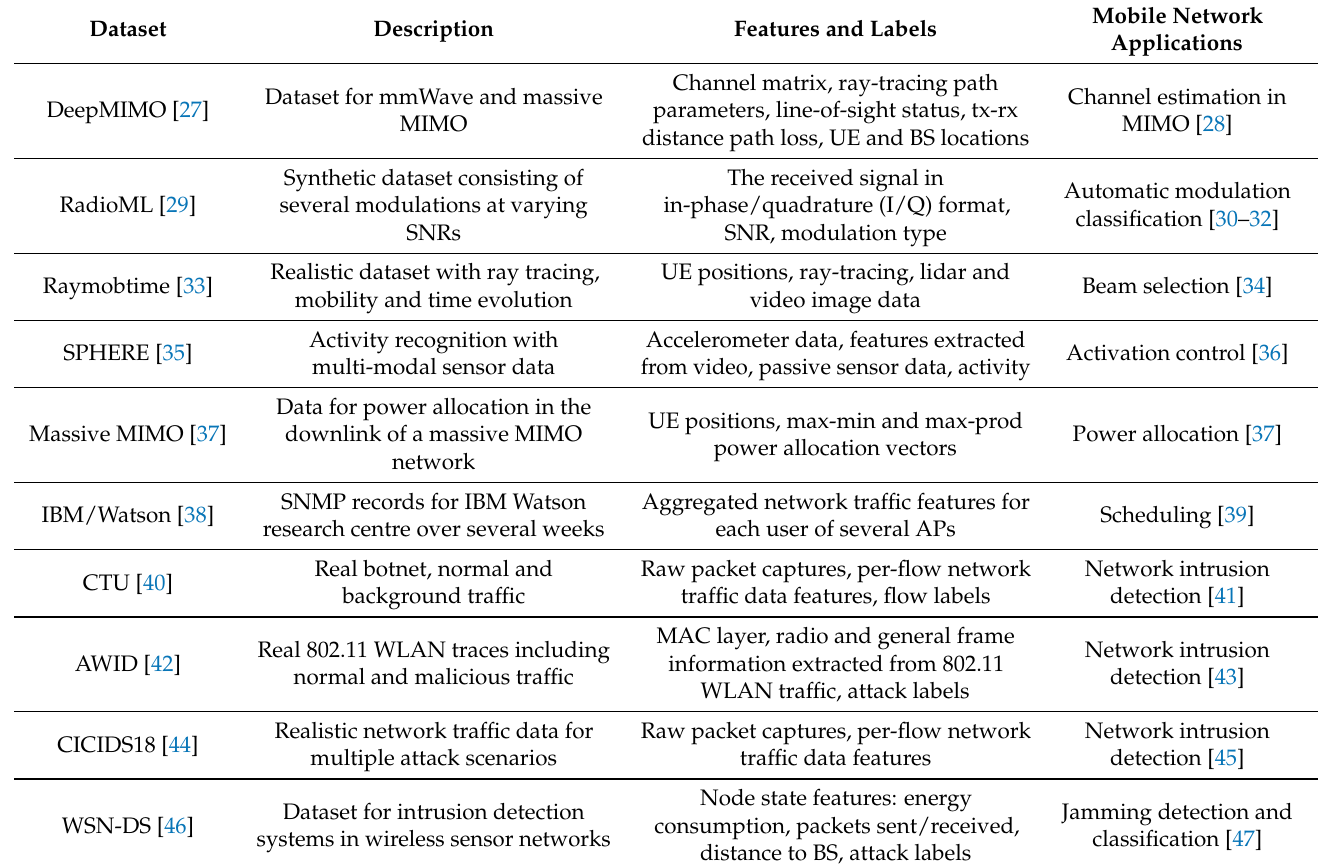
Table 1. Mobile network datasets used by researchers for training AI/ML